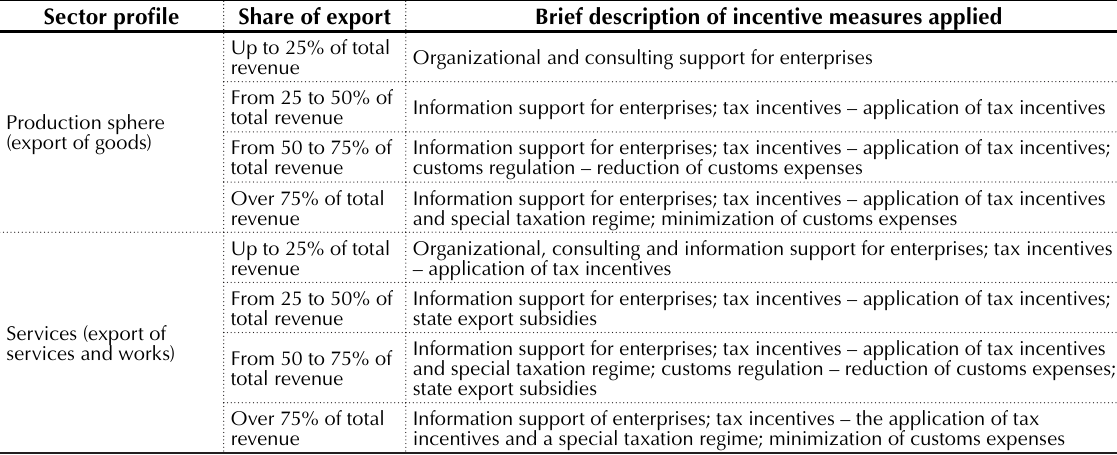
Source: Compiled by the